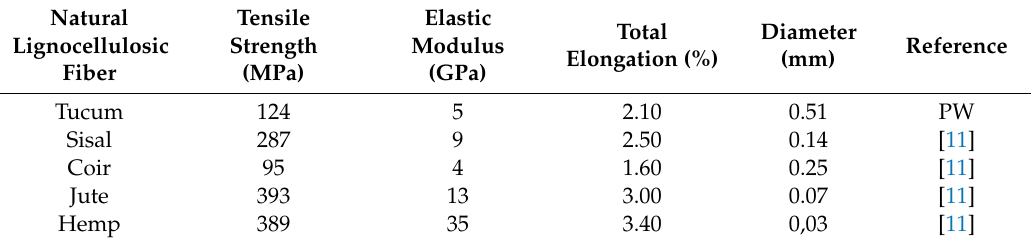
Table 1. Preliminary tensile properties and diameter of tucum as compared to others well-known natural fibers.